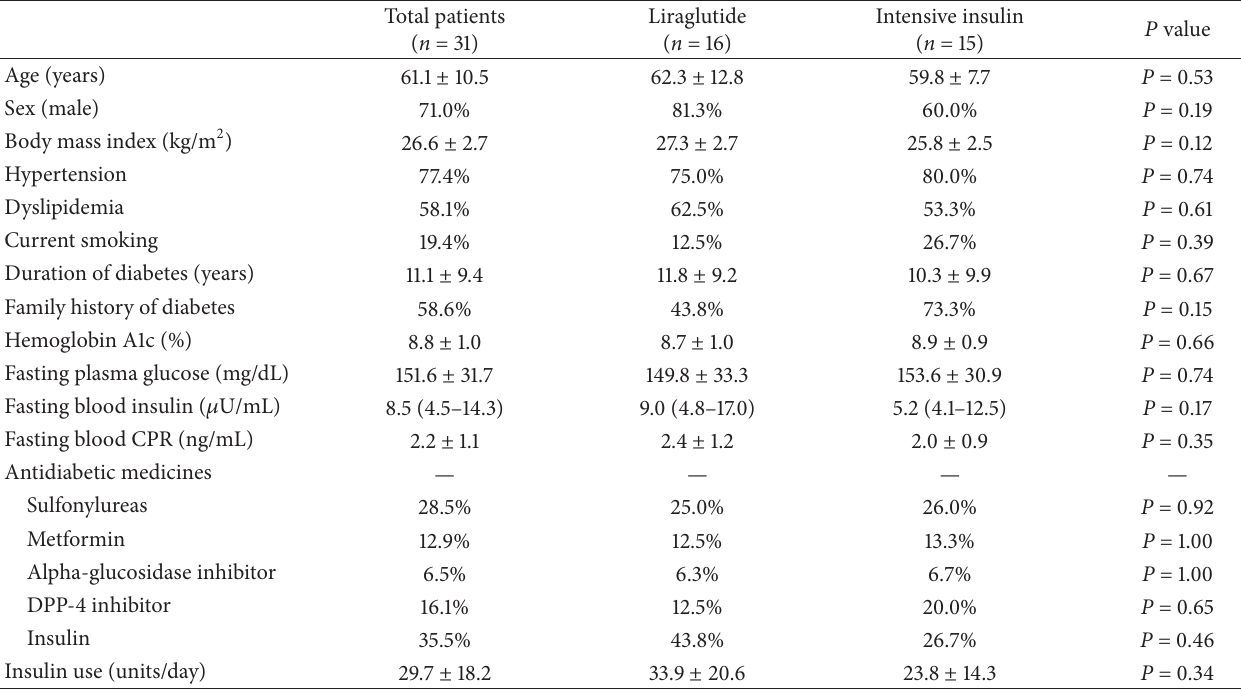
Table 1: Baseline clinical